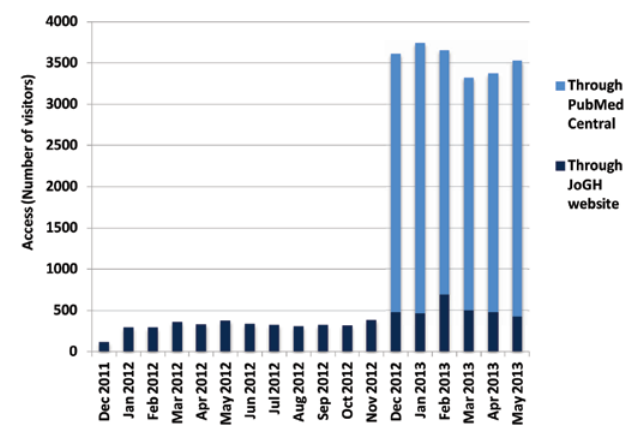
Figure 3. Access to the content of Journal of Global Health ( JoGH ), measured in number of visitors to the website (http://jogh.org) and number of visitors to journal’s PubMed Central site (Decem- ber 2011 – May